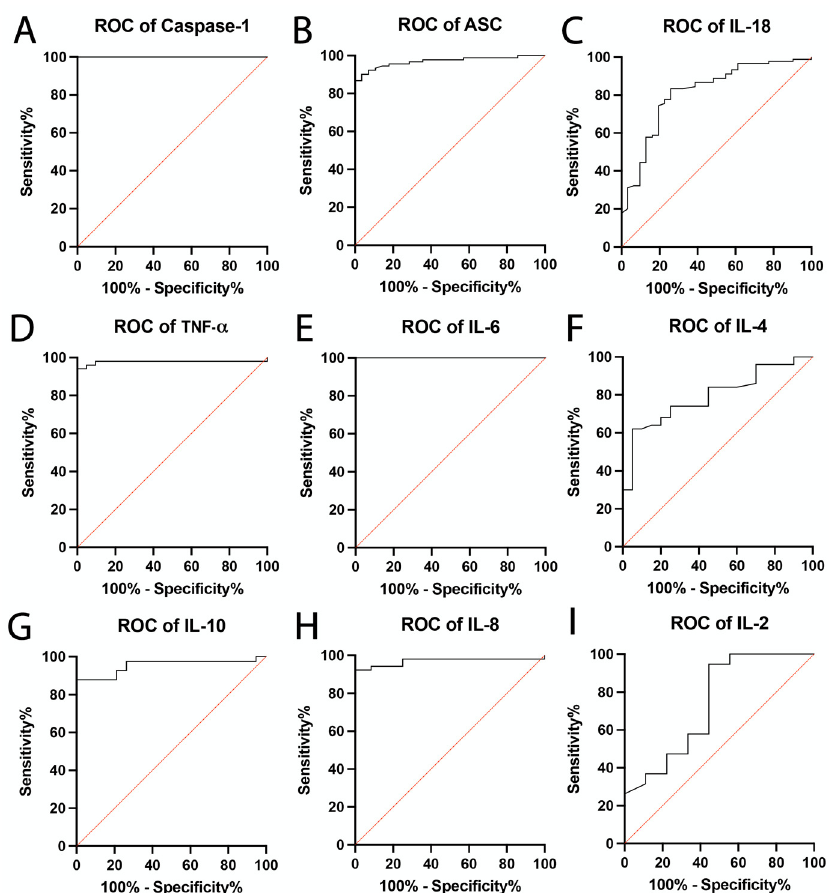
Figure 2. ROC of Inflammatory Biomarkers. ROC and AUC were calculated for each inflammatory cytokine and inflammasome proteins that were significantly different when comparing healthy uninjured controls and TBI patients. ( A ) Caspase-1: N : Control: 31, TBI: 78; ( B ) ASC: N : Control: 28,